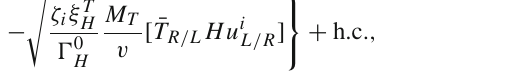
LHC (HE-LHC) with 27 TeV c.m. energy [75] and